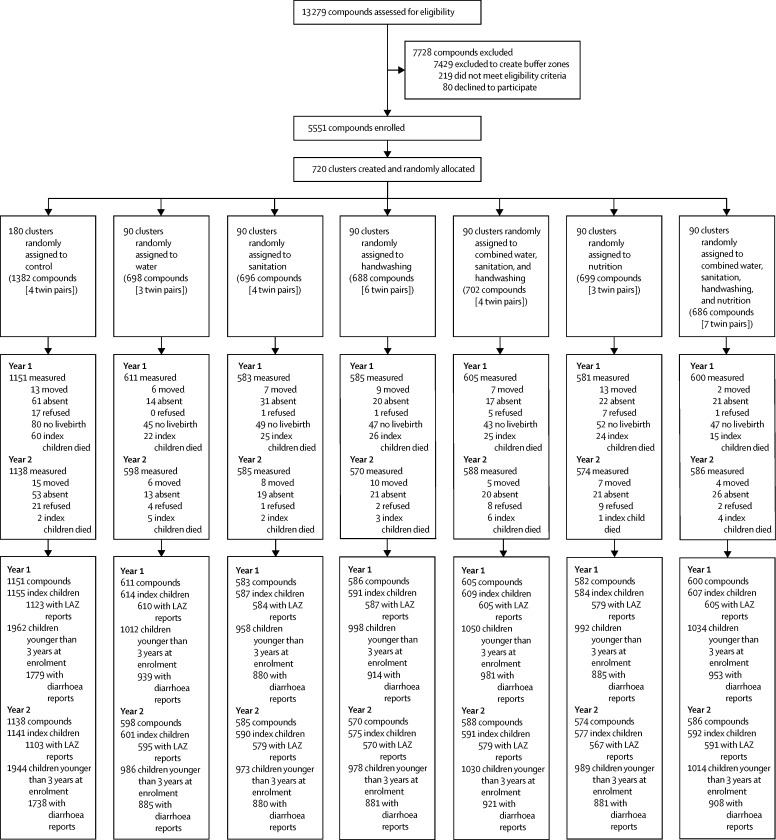
Trial profile and analysis populations for primary outcomesLAZ=length-for-age Z scores.